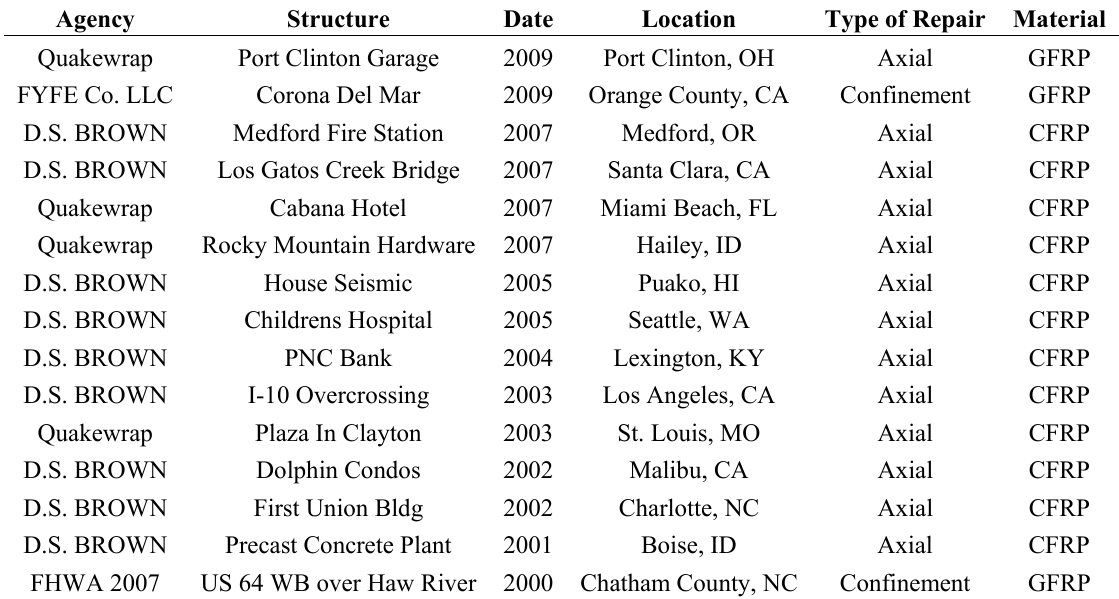
Table 3. Selected field application projects: columns retrofitted for axial loads or